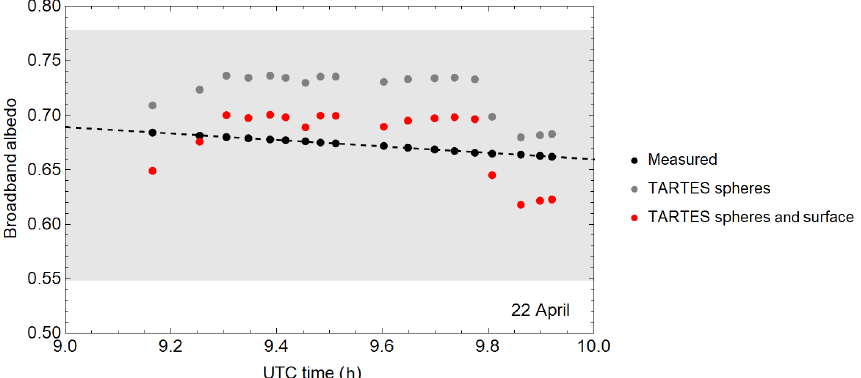
Figure 13. Measured and modelled blue-sky albedo values at Mantovaaranaapa on 22 April 2009. Each modelled point is an average corresponding to three individual plate profiles taken from the same surface. The empirical albedo values are likewise averages of the three individual points recorded using the Kipp & Zonen albedometer CM14 at the time of taking the profile photos. The shaded area shows the variation range of the broadband reflectance values measured using the ASD spectrometer.